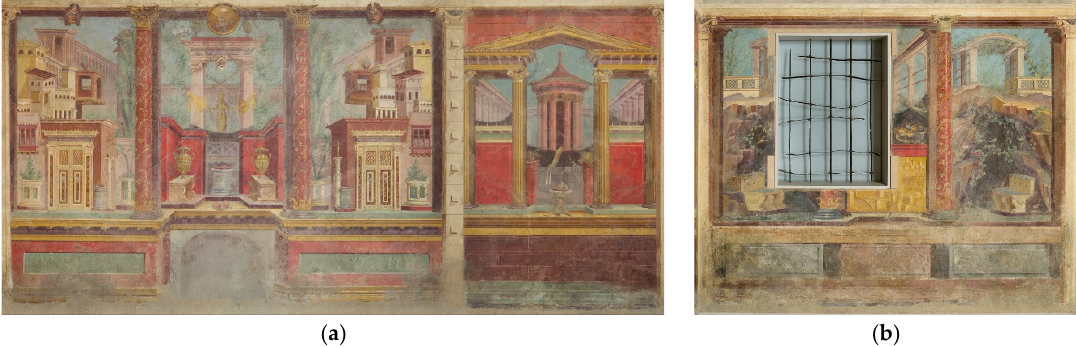
Figure 2. West ( a ) and end ( b ) walls of the cubiculum (Room M) from the Villa of P. Fannius Synistor